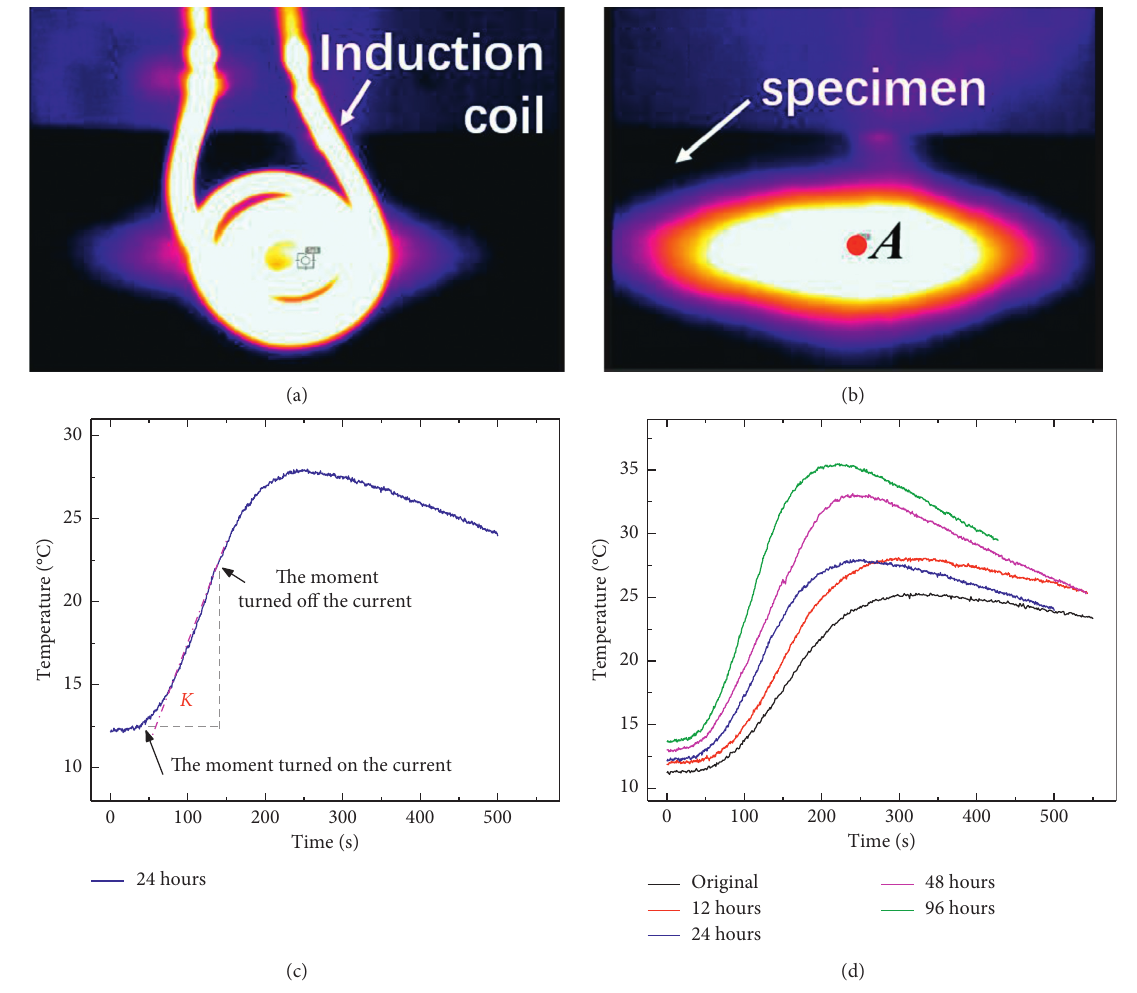
Figure 3: The thermograph of a sample surface with (a) and without (b) the induction coil, and the point of temperature measurement is labeled “A” in (b). (c) The surface temperature depends on the duration of the entire eddy current heating process, and the fitting line is displayed only for the heating process. (d) The surface temperature-time curves for the different corroded stages of specimen